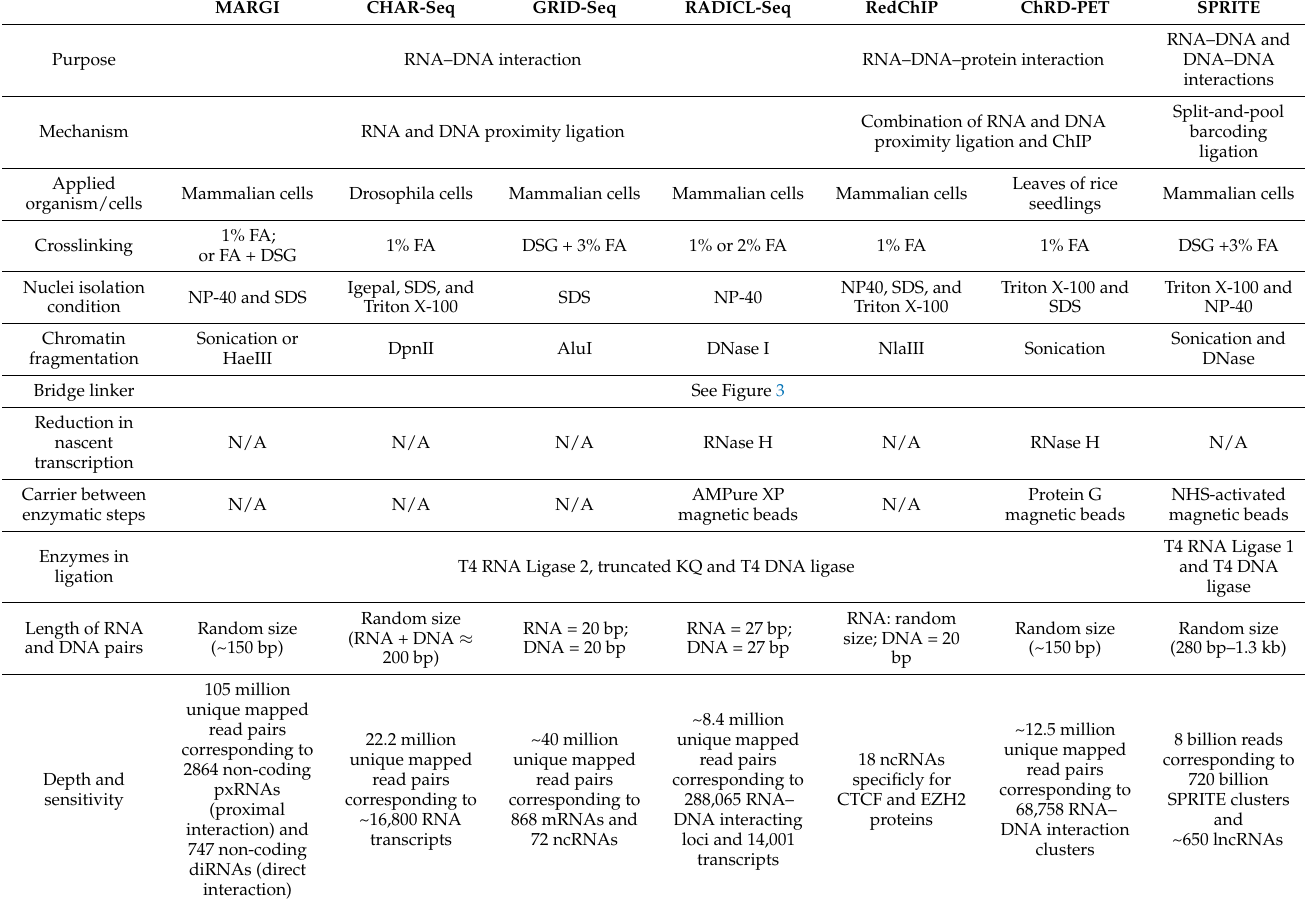
Table 1. Comparison of ‘all-to all’ approaches for identifying lncRNA–DNA